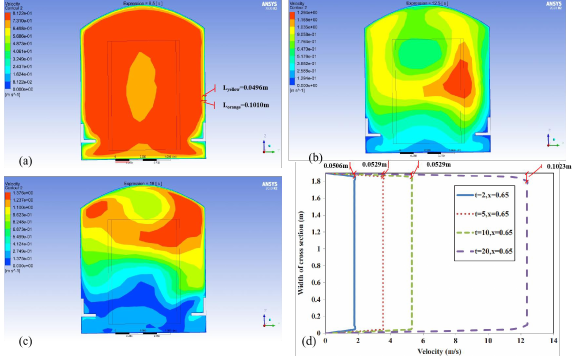
Figure 4 . Velocity contour map of interior induced flow